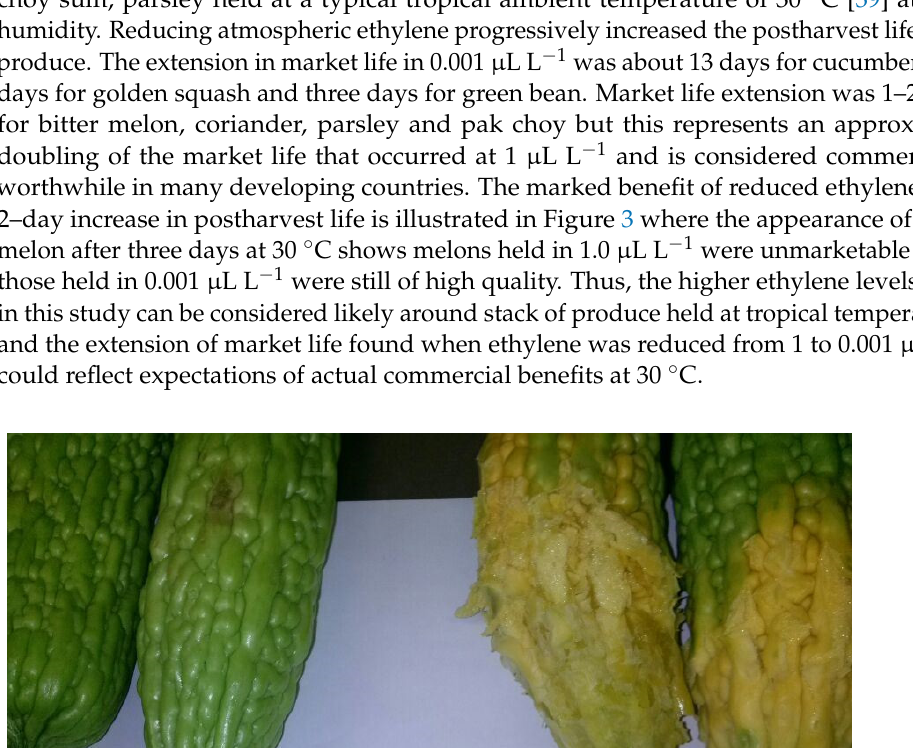
reducing the storage temperature by 10 ◦